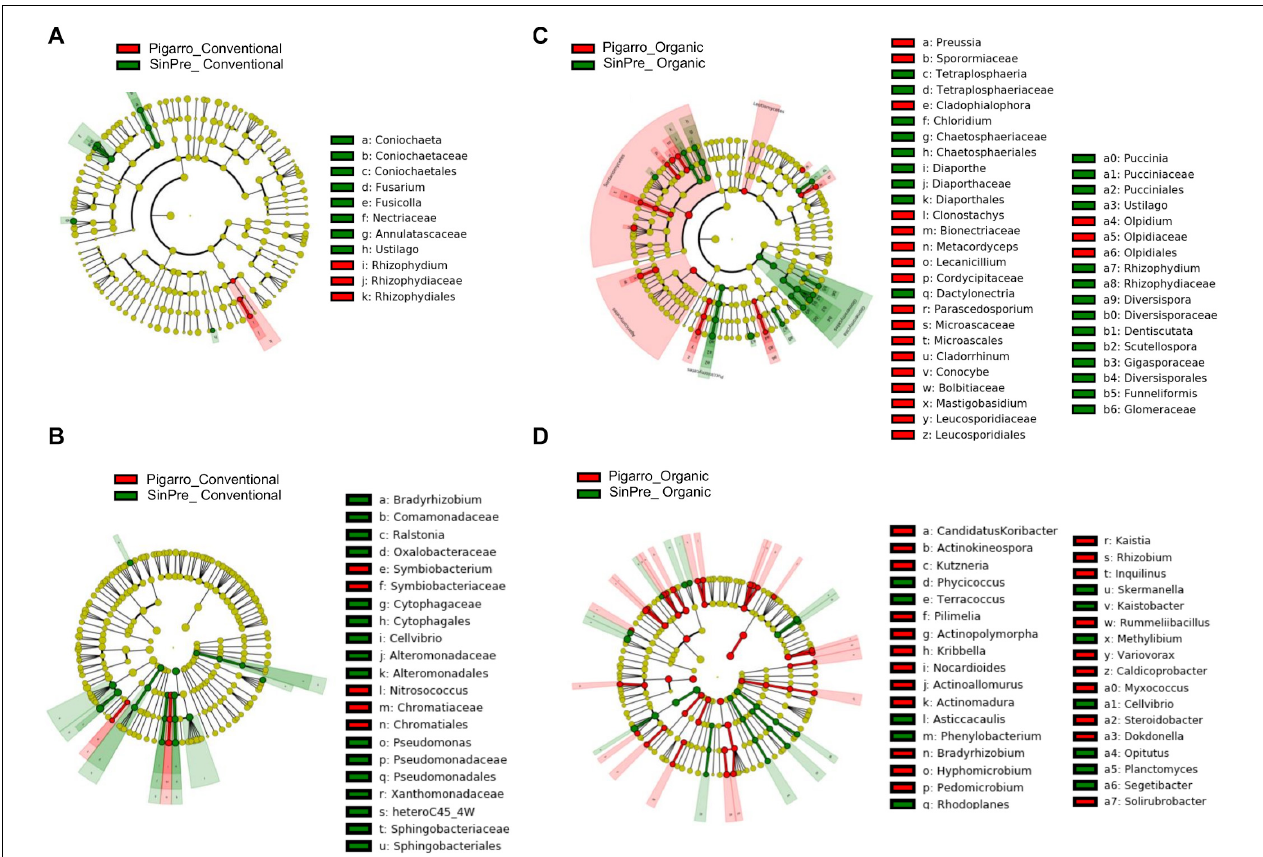
FIGURE 4 | Linear discriminant analysis (LDA) combined with effect size (LEfSe) was used to identify the most differentially abundant taxa among the population genotypes in the rhizosphere of maize. Cladogram generated by LEfSe indicating differences of fungi (A,B) and bacteria (C,D) at the phylum, class, family, and genus levels (relative abundance, ≤ 0.5%). Each successive circle represents a phylogenetic level. The red and green circles mean that “Pigarro” conventional and organic ( red ) and “SinPre” conventional and organic ( green ) showed differences in relative abundance; yellow circles mean non-significant differences. Differing taxa are listed on the right side of the cladogram . Bar graph showing the LDA scores for bacteria is represented in Supplementary Figure 1 . Only taxa meeting an LDA significant threshold > 2 are shown.